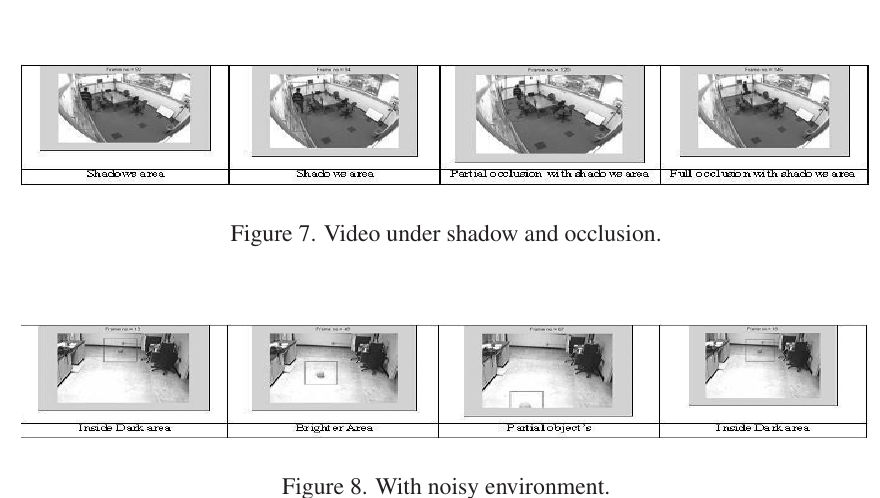
Figure 8. With noisy environment.